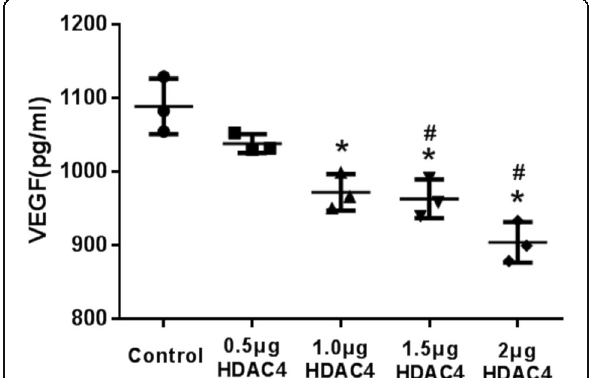
Fig. 7 ELISA analysis of VEGF in media. VEGF content in media following the transfection of various doses of GFP-HDAC4 DNA into isolated murine chondrocytes as detected by ELISA. Data are expressed as mean ± SEM. * P < 0.05 vs. vehicle group. # P < 0.05